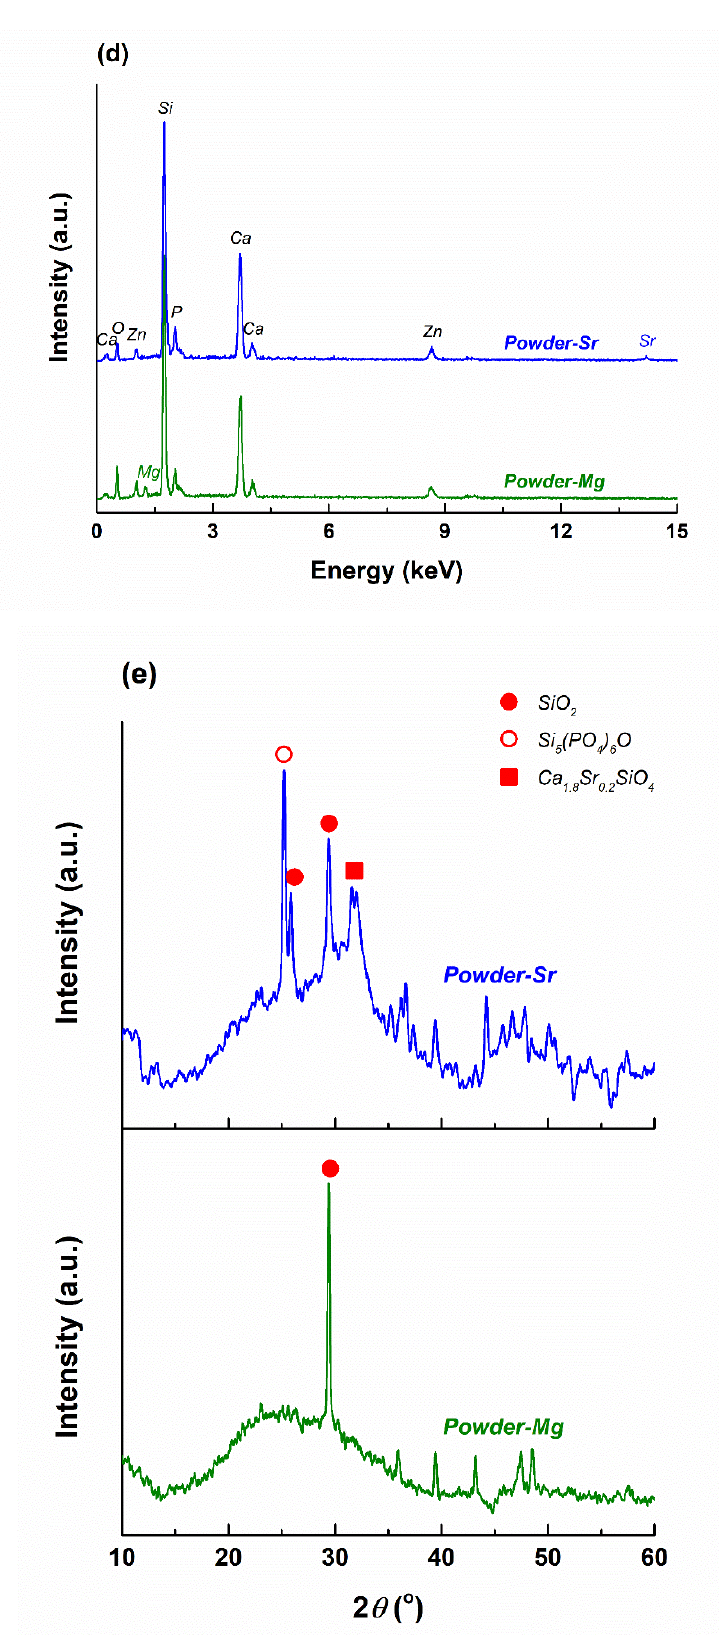
Figure 1. ( a ) Thermal analyses on the dried gels, SEM images of: ( b ) Powder-Mg and ( c ) Powder-Sr, ( d ) EDX spectra and ( e ) XRD patterns of the calcined powders.